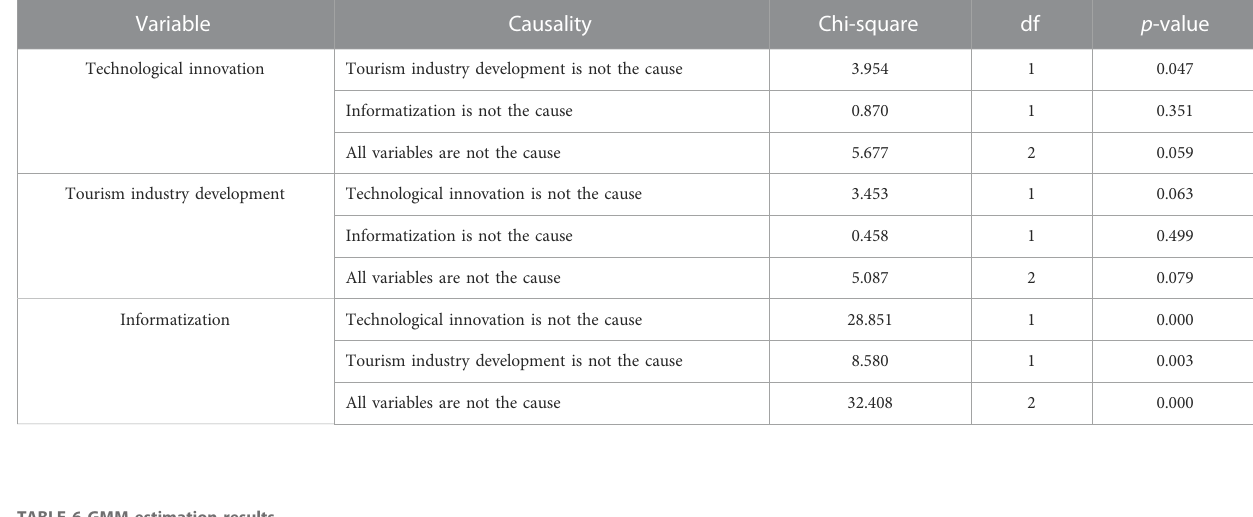
TABLE 6 GMM estimation results.